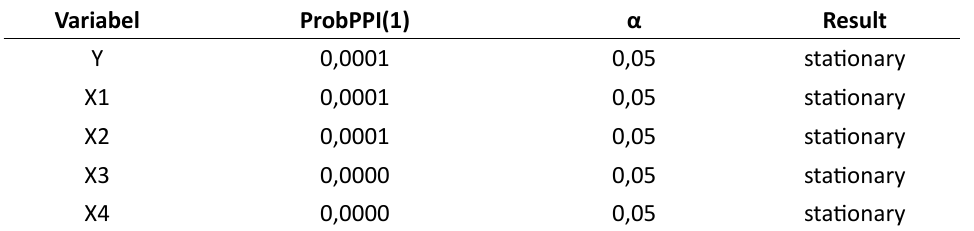
Table 3: Stationary Test Results with the Phillips-Perron First Difference Test Level Variabel ProbPPI(1) α Result Y 0,0001 0,05 stationary X1 0,0001 0,05 stationary X2 0,0001 0,05 stationary X3 0,0000 0,05 stationary X4 0,0000 0,05